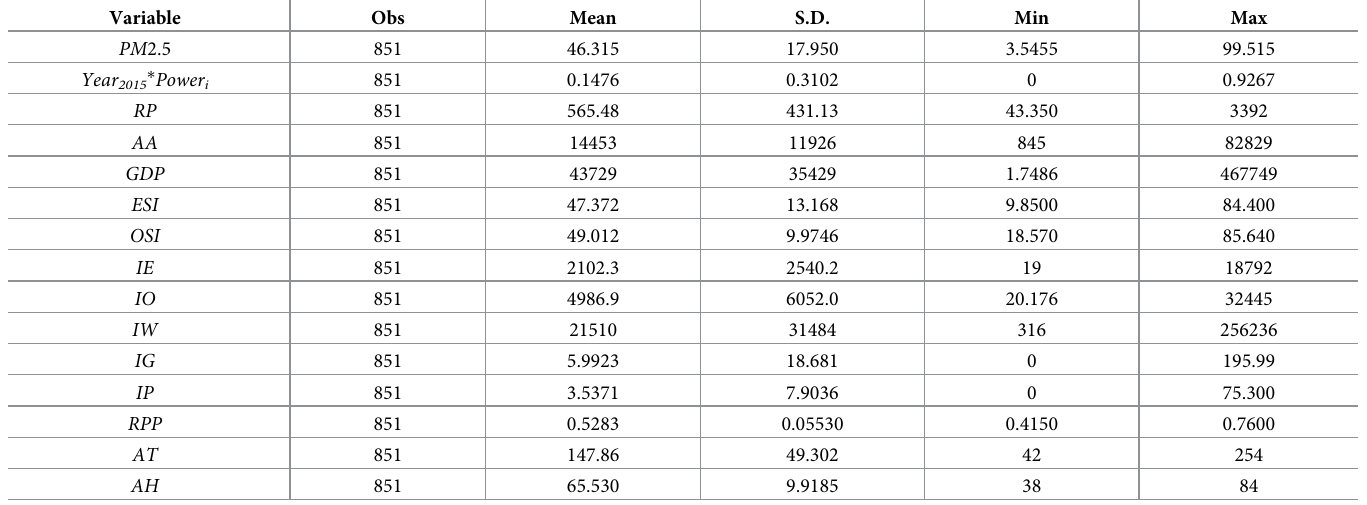
Table 1. Descriptive